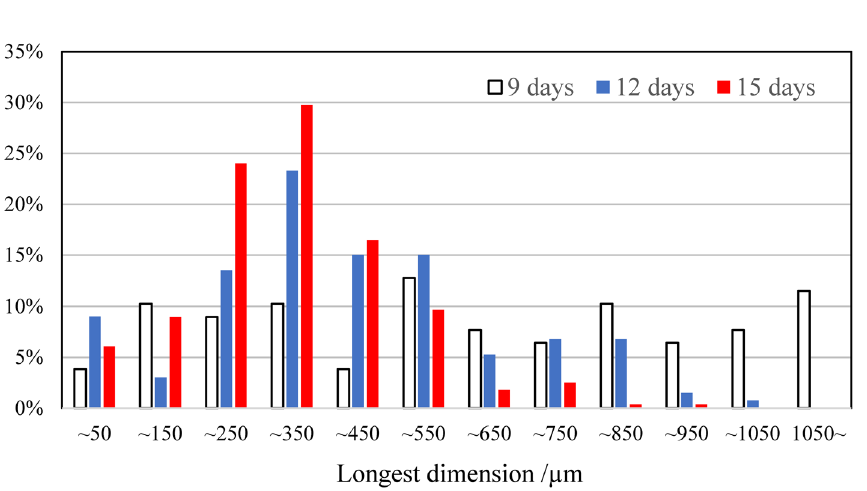
Figure 6. Longest dimension distributions of 9-, 12- and 15 days-AOP degraded PP samples in the seawater. Particle numbers: 9 days = 79, 12 days = 136, 15 days =